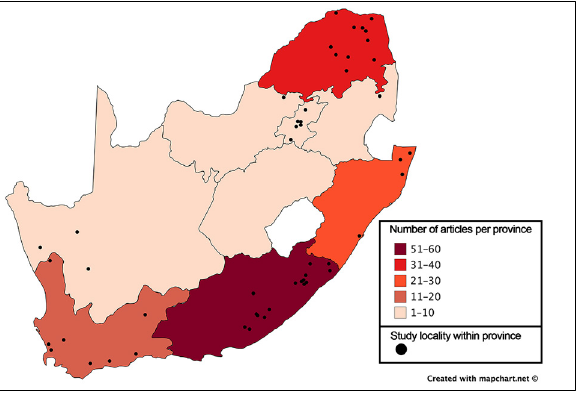
Figure 2: Distribution of biocultural diversity research within South Africa. The map plots spatial research focus (grouped by province) of 142 of 263 peer-reviewed articles published between 1990 and 2018. The remaining 121 articles have a national research focus.